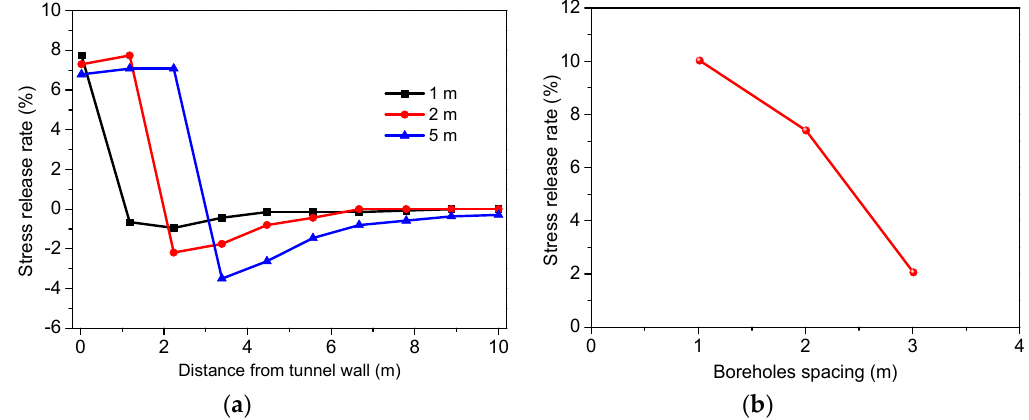
Figure 9. The effect of boreholes on stress release rate: ( a ) Boreholes length and ( b ) boreholes spacing.